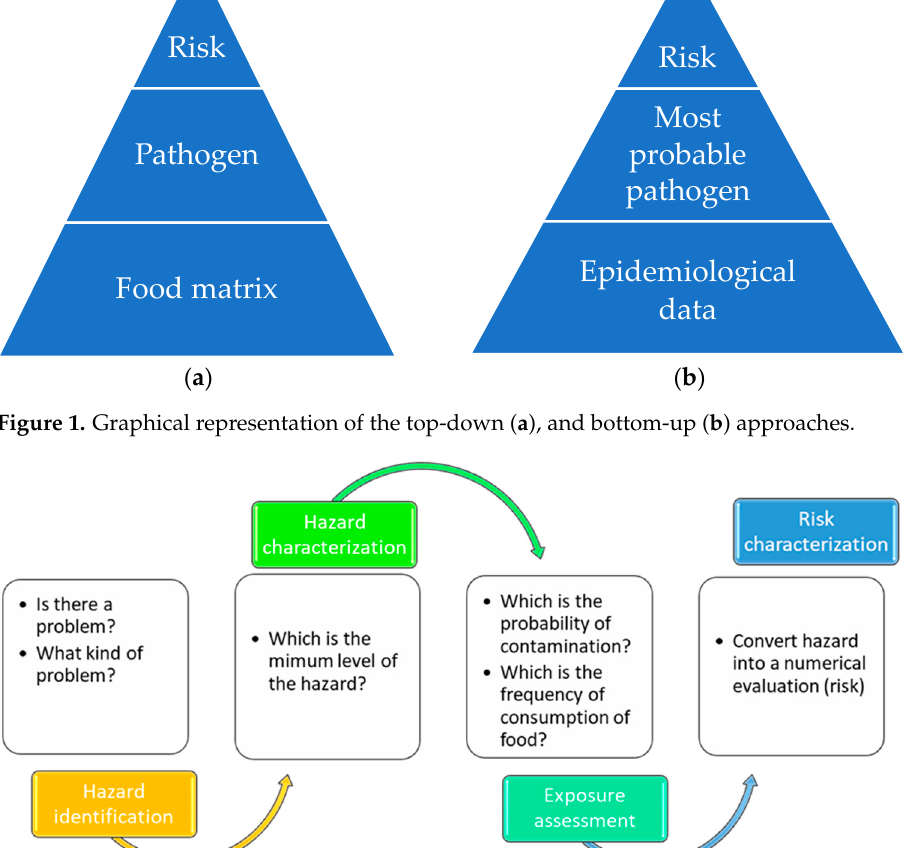
Figure 2. Steps and questions in the Risk Assessment process.